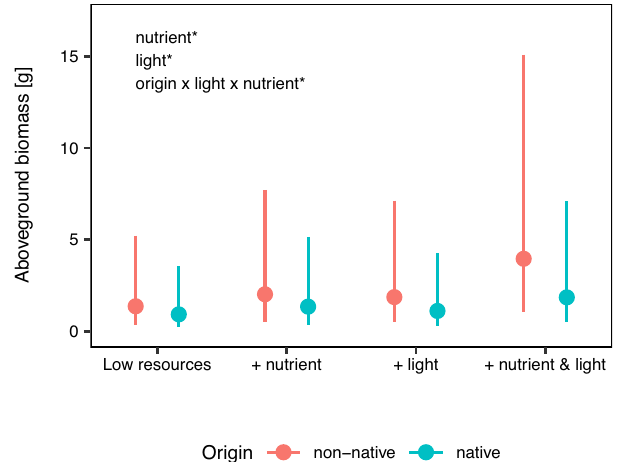
Fig. 2 Effects of nutrient and light availabilities on competitive outcomes between native (blue) and non-native (red) plants. The outcome is indicated by the difference in average biomass production between native and non-native plants across competition treatments (i.e. without competition, and with intra- and interspeci fi c competition). For example, higher biomass production of non-native plants indicates that non-natives will outcompete natives. Error bars indicate 95% CIs. Signi fi cant effects are indicated in the left upper corner (see Supplementary Table 2 for details).